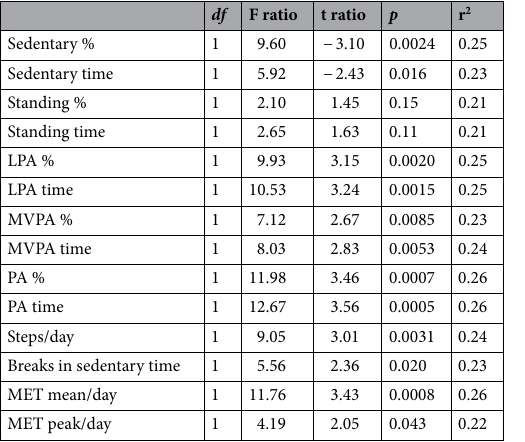
Table 6. Associations between plasma HDL-Cholesterol and accelerometer measures, least squares effect tests with sex, age and cholesterol lowering medication included in the model. LPA light physical activity, MVPA moderate to vigorous physical activity, PA physical activity (LPA and MVPA together), MET the metabolic equivalent.